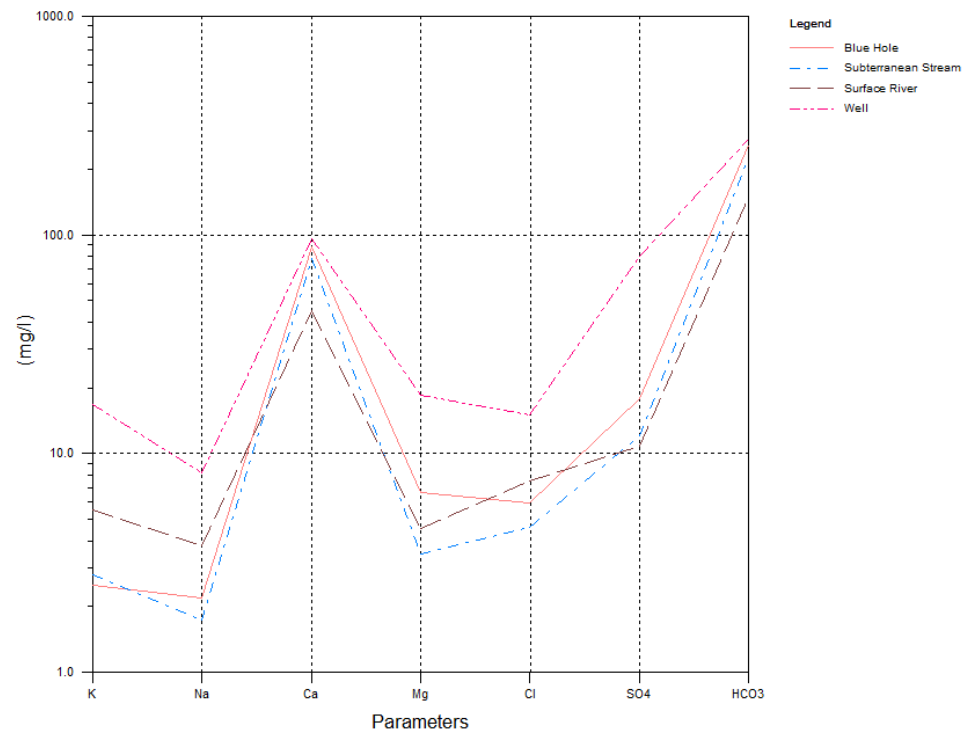
Figure 4. Schoeller diagram of major ions in surface river water and groundwater (subterranean stream water, blue hole water, well water) of the Huixian karst wetland.